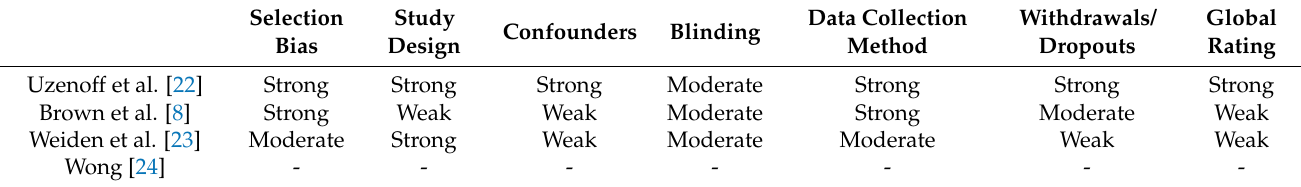
Table 3. Quality assessment using